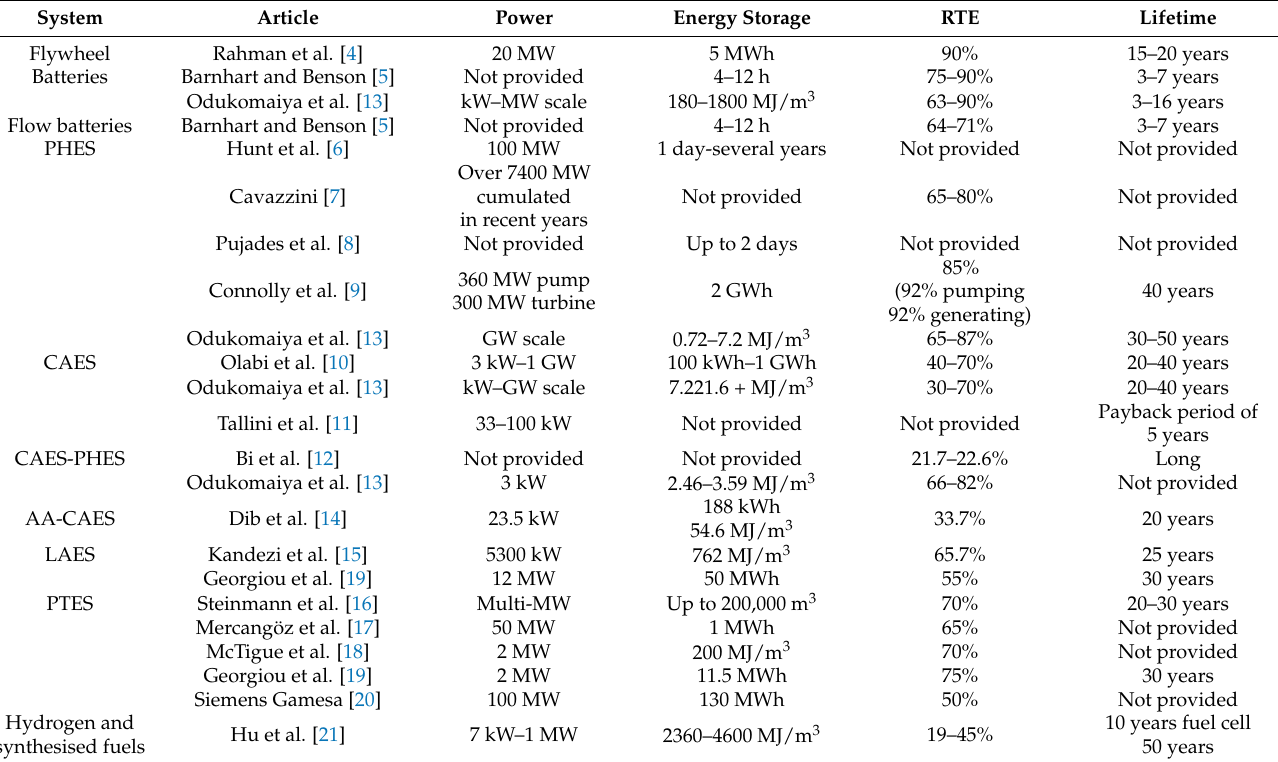
Table 1. Storage systems characteristics and